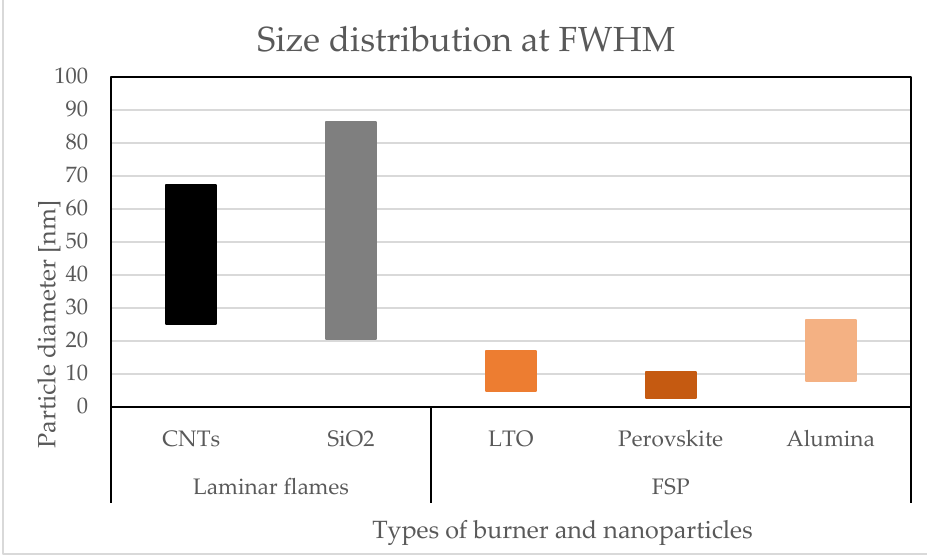
Figure 5. Comparison of particle size distribution obtained for carbon nanotubes (CNTs) [25], silica nanoparticles (SiO2) [15], Li 4 Ti 5 O 12 (LTO) [62] , perovskites with added iron particles [27] , and alumina NPs [18].